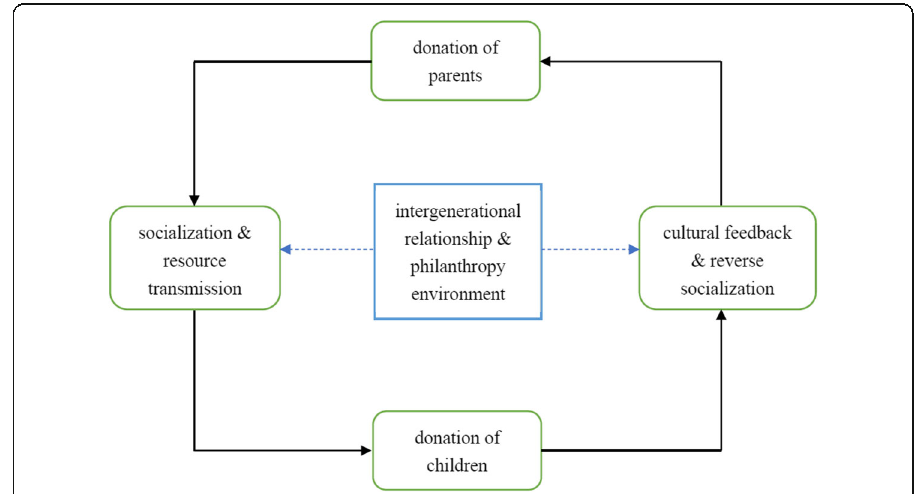
Fig. 1 Diagram of the intergenerational influence on charitable